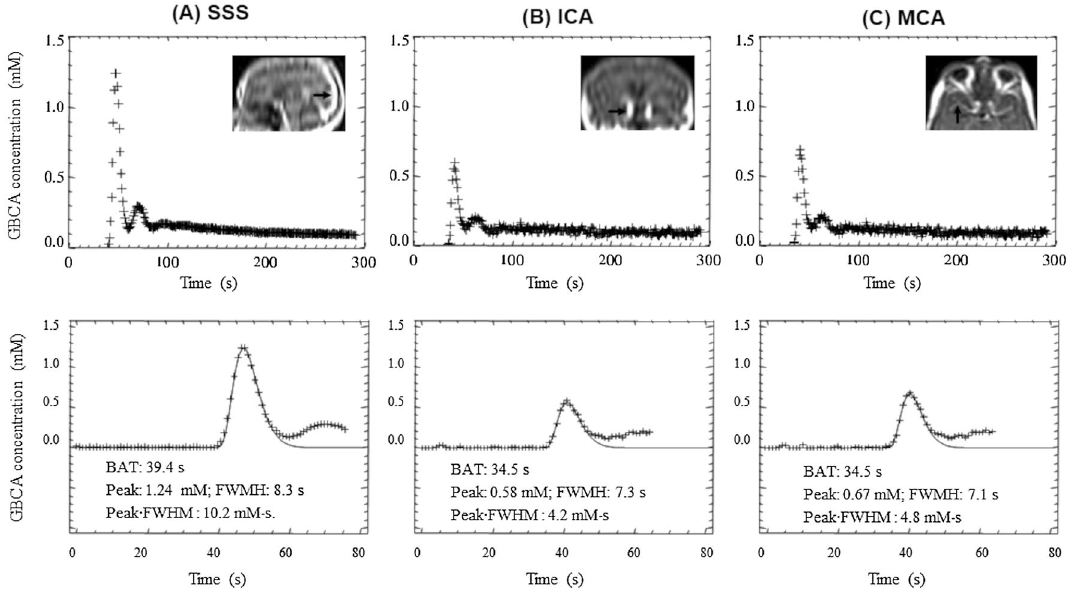
Figure 2. Typical plasma GBCA concentration–time curves C p (t) ( top row ) derived from the vertical segment of the SSS ( A ); the ICA ( B ); and horizontal segment of the middle cerebral artery MCA ( C ) following a bolus injection of 2mls of GBCA (0.016 mmol/kg) at a rate of 2 ml/s. The first-pass data are fitted using a gamma variate function, which excludes contrast-agent bolus recirculation ( bottom row ). Images obtained from a patient with a sporadic VS imaged at 1.5 T. GBCA = Gadolinium-based contrast agent; ICA = Internal carotid artery; MCA = Middle cerebral artery; SSS = Superior sagittal